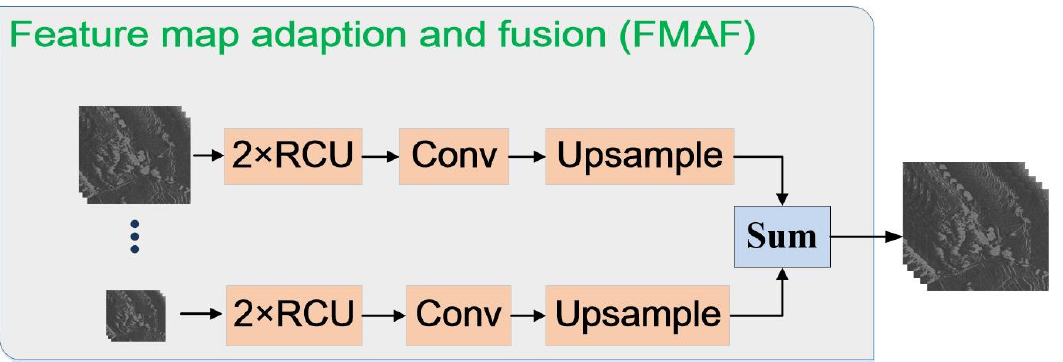
Figure 2. The Feature Map Adaption and Fusion (FMAF) architecture.